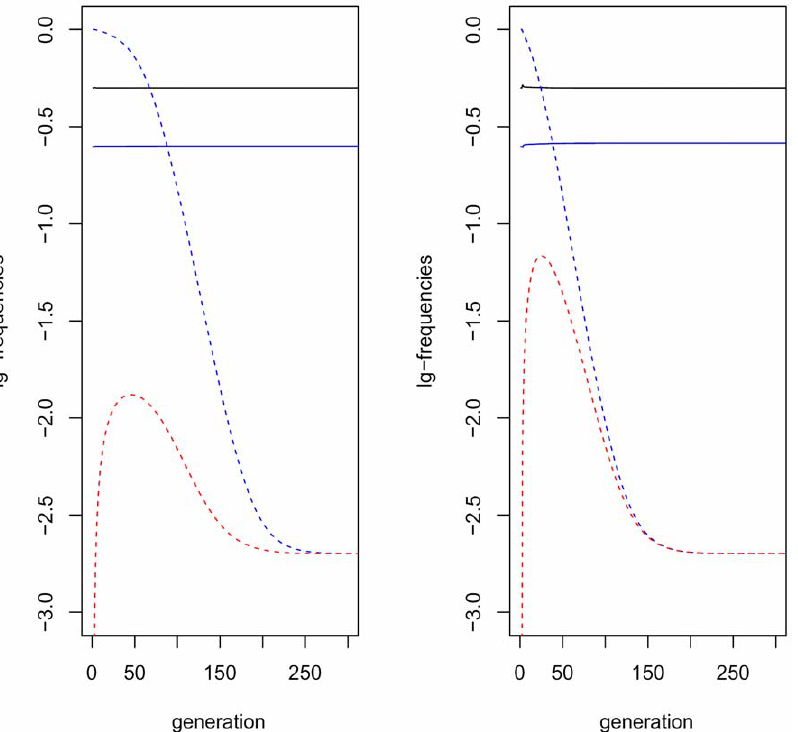
Figure 1. Dynamics of the deleterious mutation. In this figure, dynamics of the deleterious mutation is illustrated by two examples. In both panels, the black lines represent the proportion of phenotypic females, the blue lines the proportion of Y chromosomes out of all sex chromosomes, the dashed blue lines prevalence of the deleterious mutation in Y chromosomes, and the dashed red lines prevalence of the deleterious mutation in X chromosomes. (Note the log 10 scale of the y axis.) The rates of sex reversal are 0.01 (panel A) and 0.10 (panel B). The rest of the parameters are as in ‘Baseline’, Table